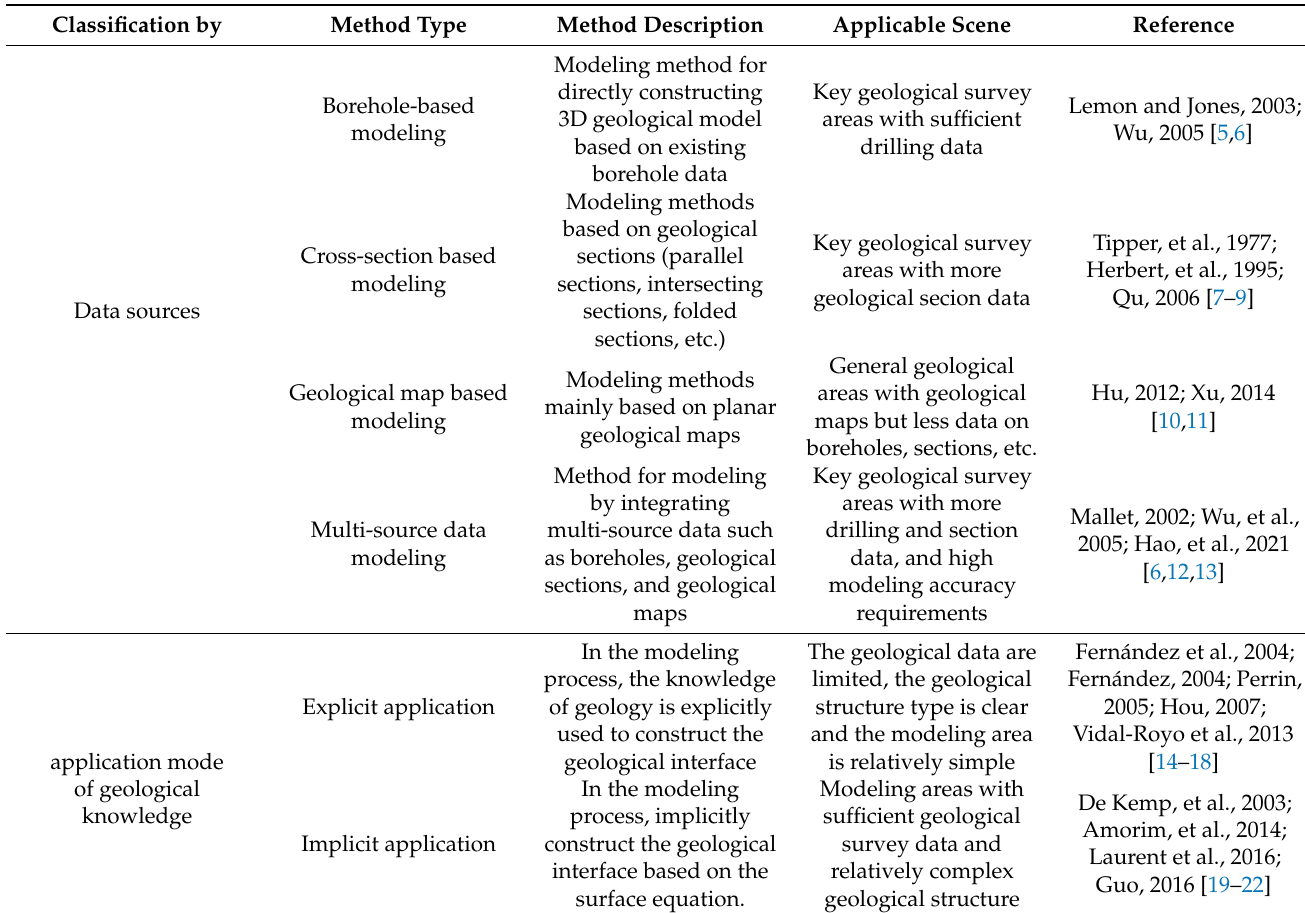
Table 1. Classification of Modeling